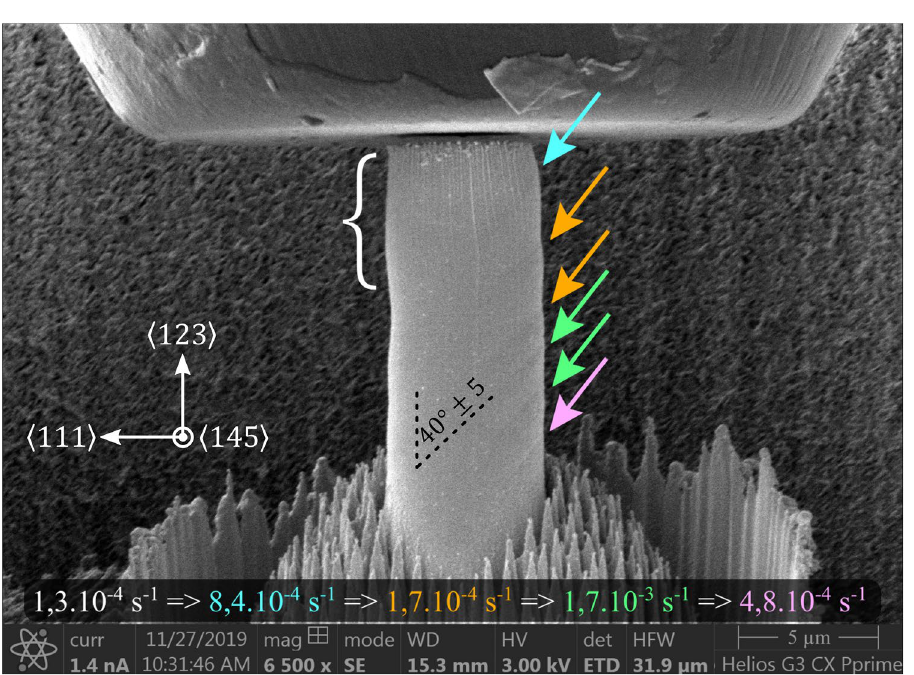
Figure 6. SEM snapshot from the video in supplement material showing an InSb micro-pillar of 5 µm in diameter after the deformation by the strain rate jumps: the white bracket delimits the swelling on top of the pillar, the arrows locate the slip traces at the surface and the different colors indicate in which strain rate regime slip bands